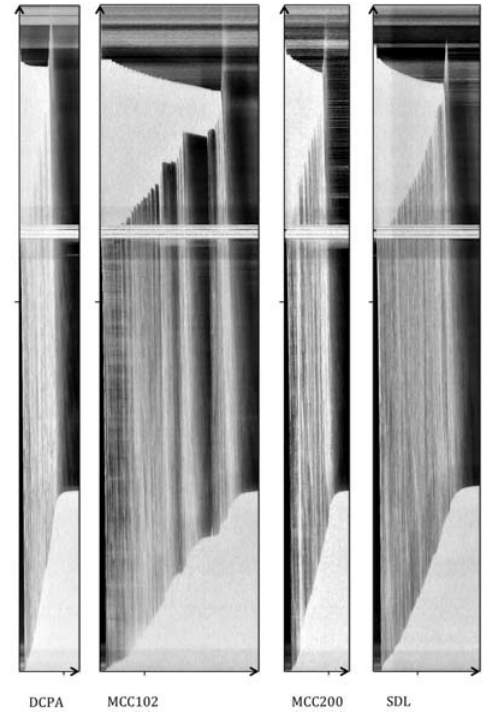
Figure 6. Spatial-temporal images of powder flow in pipes with a closed outlet for all tested materials: dicalcium phosphate anhy- drous (DCPA), microcrystalline cellulose MCC102 and MCC200, and spray-dried lactose (SDL). Horizontal marks at the image bot- tom correspond to 5 s, and the vertical left positioned lines corres- pond to 1000 mm. The original images are inverted and the contrast enhanced for illustration